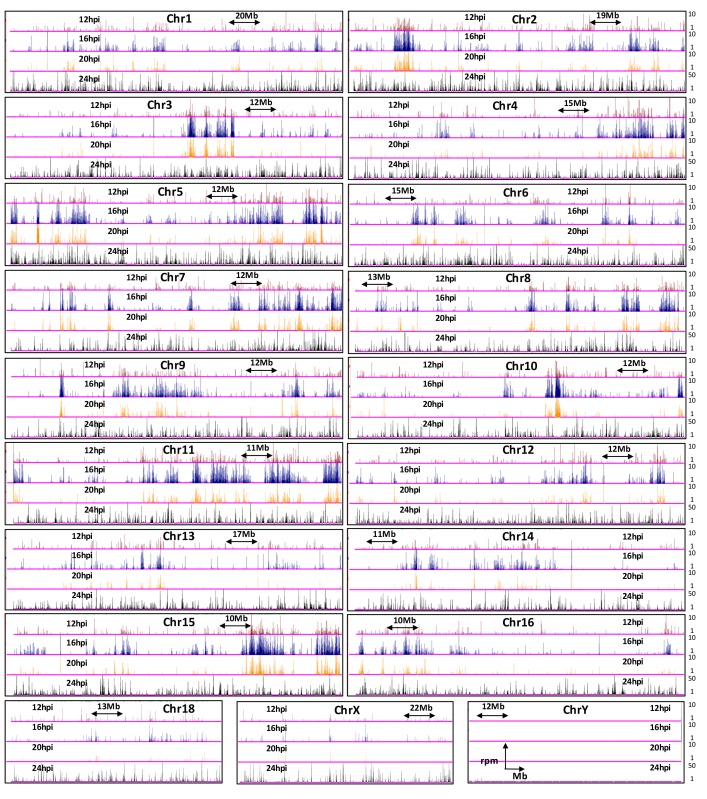
Genome browser snapshots of MVM interaction sites on all chromosomes in the mouse genome.12 hpi (red), 16 hpi (blue), 20 hpi (orange) and 24 hpi (black) timepoints are shown. The y-axis values are depicted on the right hand side. Since MVM interaction at 24 hpi did not show a characteristic distribution and had high rpm values (consistent with overwhelming levels of MVM replication in the host cell nucleus), it was not used for quantile normalization of interaction sites at 12, 16 and 20 hpi. Chromosomes 17 and 19 are presented in Figure 2B.